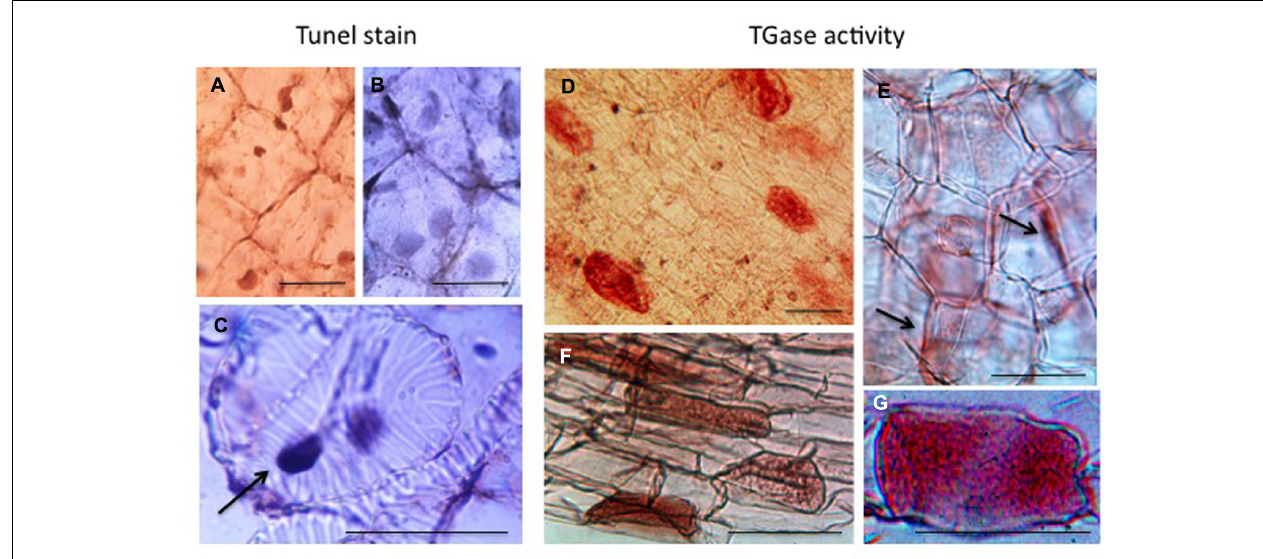
dansyl-cadaverine and after extensive washing, immuno cytochemically recognized by an anti-dansyl antibody. Cells positive to conjugated cadaverine were scattered among others ( D and F ). TGase products were found either mainly in the cell walls ( E , arrows) or in the whole cells ( G ). Bars: 50 μ